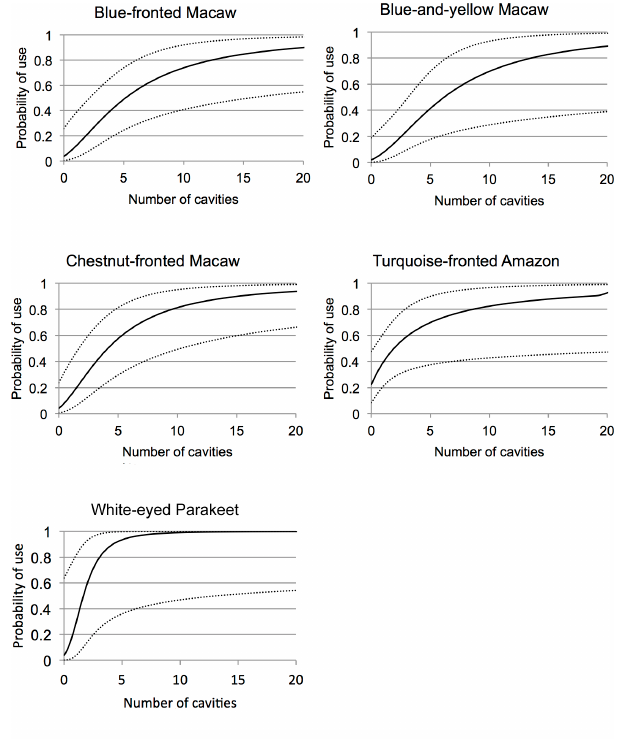
was negatively related to M-palm and fire parameters. Parameter estimates for cavities had confidence intervals that did not overlap zero (Fig. 3). Fig. 3 . Influence of number of cavities on probability of use for the five parrot species for which cavities had a substantial effect. Probabilities were estimated by using the best model of each parrot species and the following values of covariates: Blue- throated and Chestnut-fronted Macaws in the presence of M- palm, Turquoise-fronted Amazon in the absence of fire, Blue- and-yellow Macaw in the presence of selective logging, and White-eyed Parakeet on an average size island in the presence of